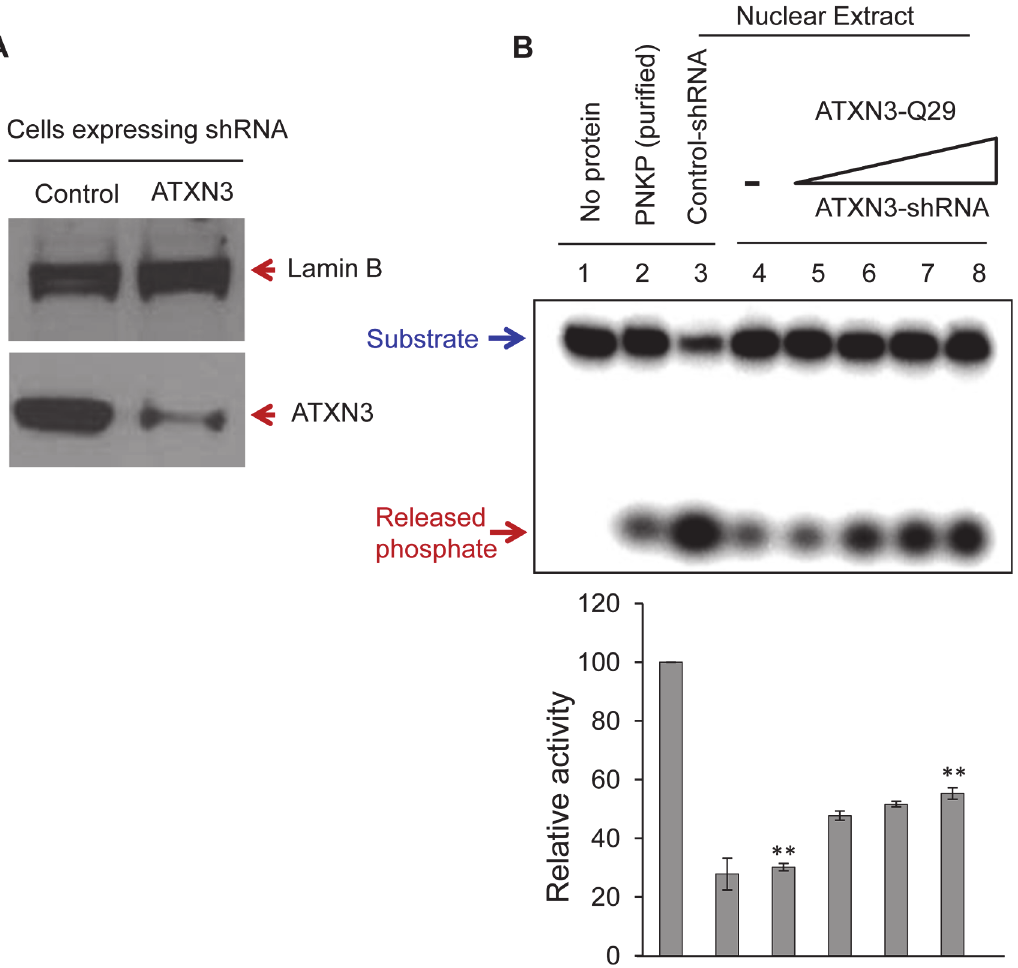
Figure 4. ATXN3 depletion decreases PNKP ’ s 3 ’ -phosphatase activity. (A) Western blot analysis showing the level of expression of ATXN3 in SH-SY5Y cells stably expressing control vs. ATXN3-shRNA. Lamin B was used as a loading control. (B) A representative gel (n = 3) showing the 3 ’ -phosphatase activity in the nuclear extract (200 ng) of control (ln 3) and ATXN3-depleted cells (ln 4). Lns 5 – 8, increasing amounts (10, 25, 50 and 100 fmol) of purified ATXN3 (WT) were added back to ATXN3-depleted nuclear extract. Quantitation of the products is represented in the histogram (n = 3, ** = P < 0.01).